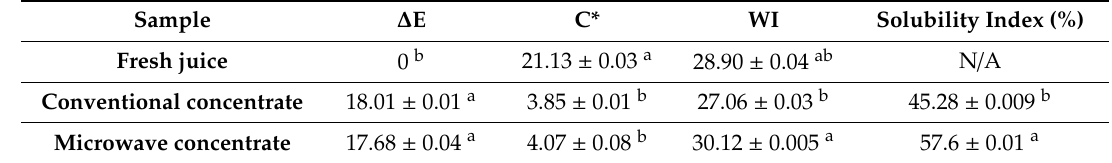
Table 3. Color and solubility of sugarcane concentrate compared with fresh